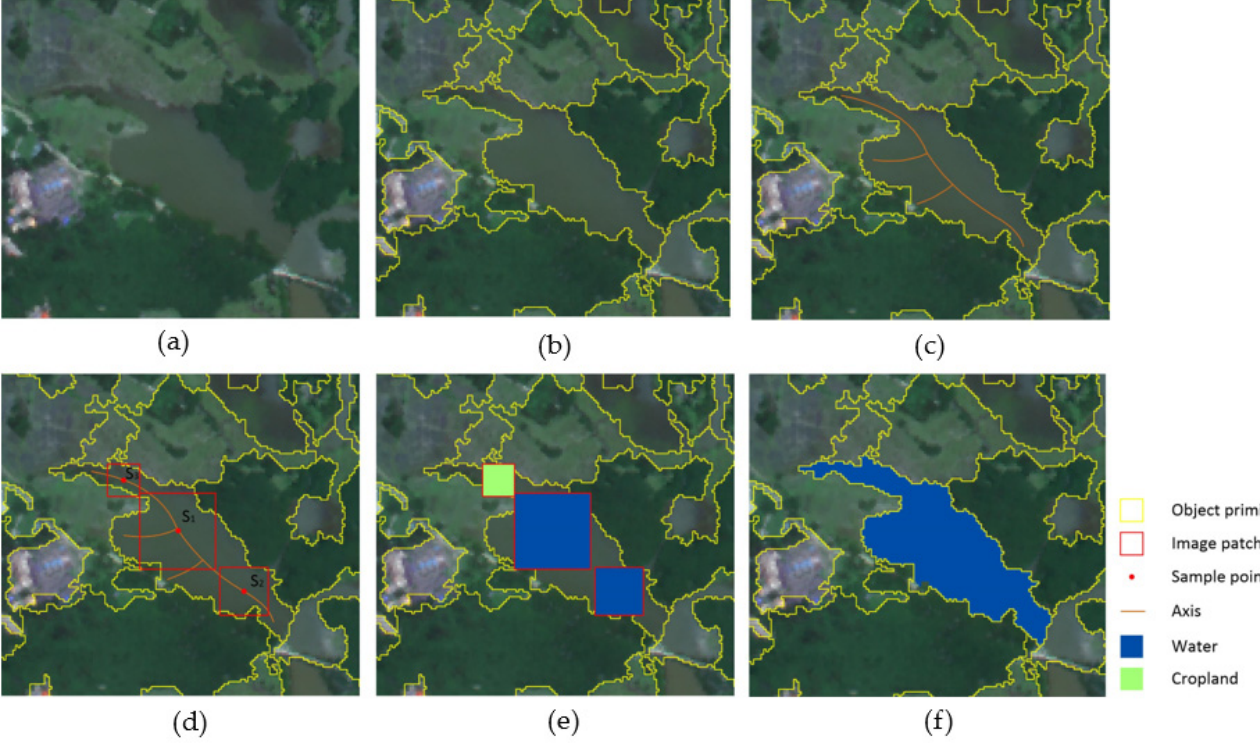
Figure 5. ( a ) GF-2 image. ( b ) The segmentation results. ( c ) The axis extraction from an object primitive. ( d ) The image patches sampled along the axes. ( e ) The classi fi cation results of image patches. ( f ) The classi fi cation result of an object primitive.